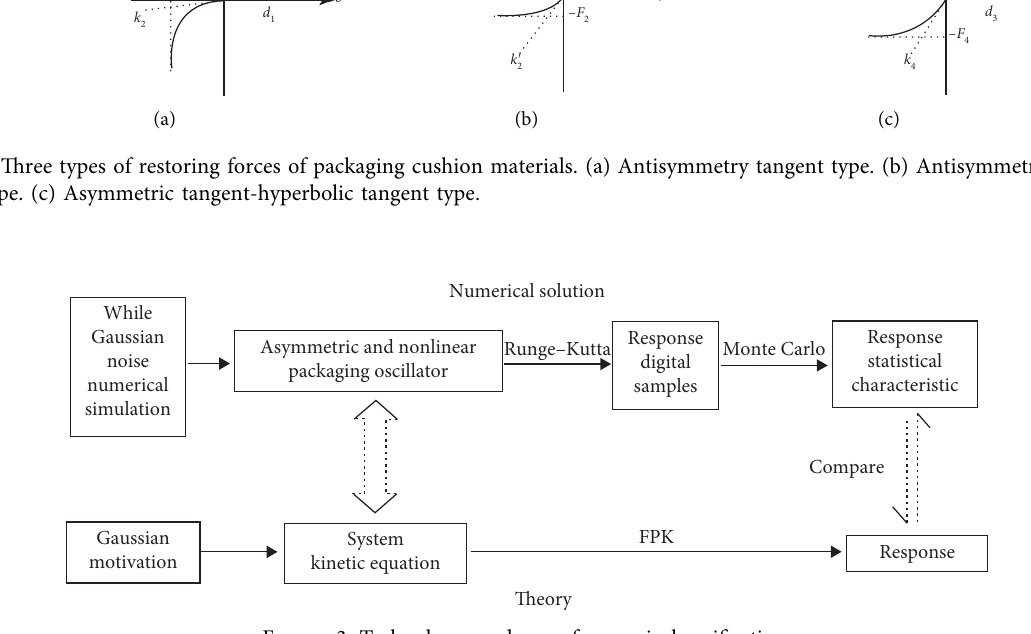
Figure 3: Technology roadmap of numerical verification.